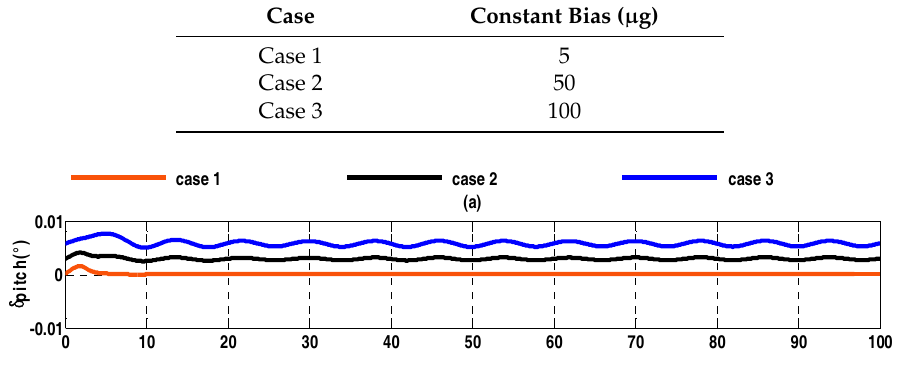
Table 1. Three different values of constant biases for accelerometer Case Constant Bias ( µ g) Case 1